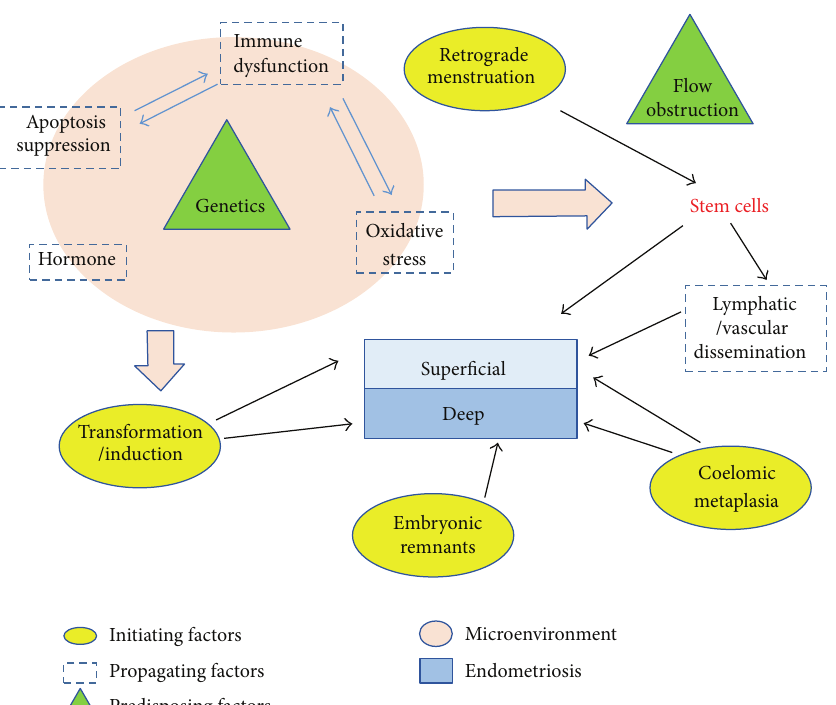
Figure 1: Summary of the proposed interplay between the different factors reported in the pathogenesis of superficial versus deep endometriosis. The different initiating, propagating, and predisposing factors are indicated through different shapes, respectively. The arrows indicate the interplay between the different factors. As indicated by the bold pink arrows, some of the labelled propagating factors create a microenvironment that impacts the differentiation of stem cells and/or the transdifferentiation of peritoneal cells into endometrial